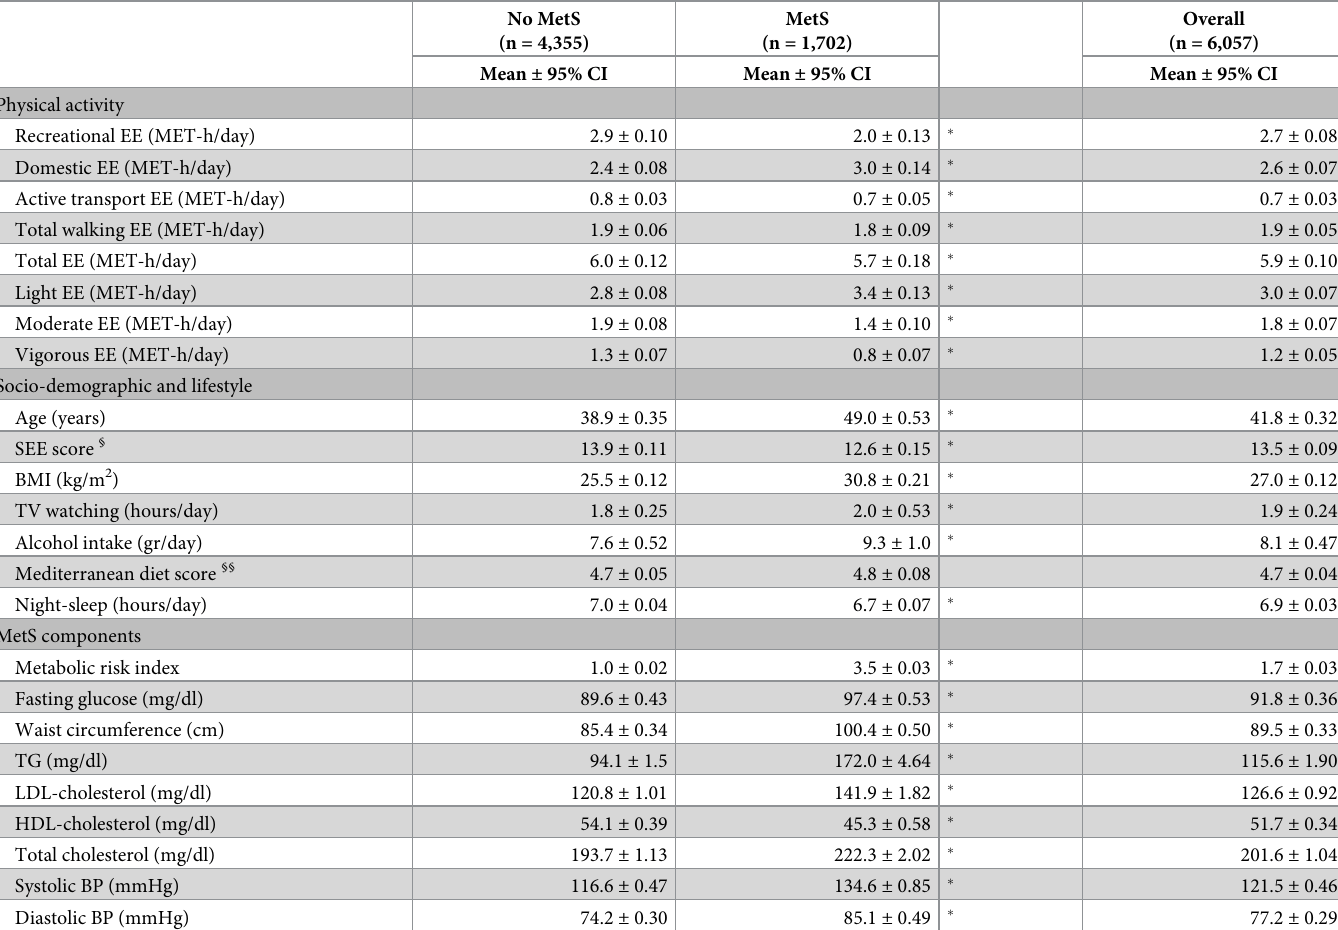
Table 2. Distribution of energy expenditure in physical activities, socio-demographic, lifestyle and metabolic syndrome